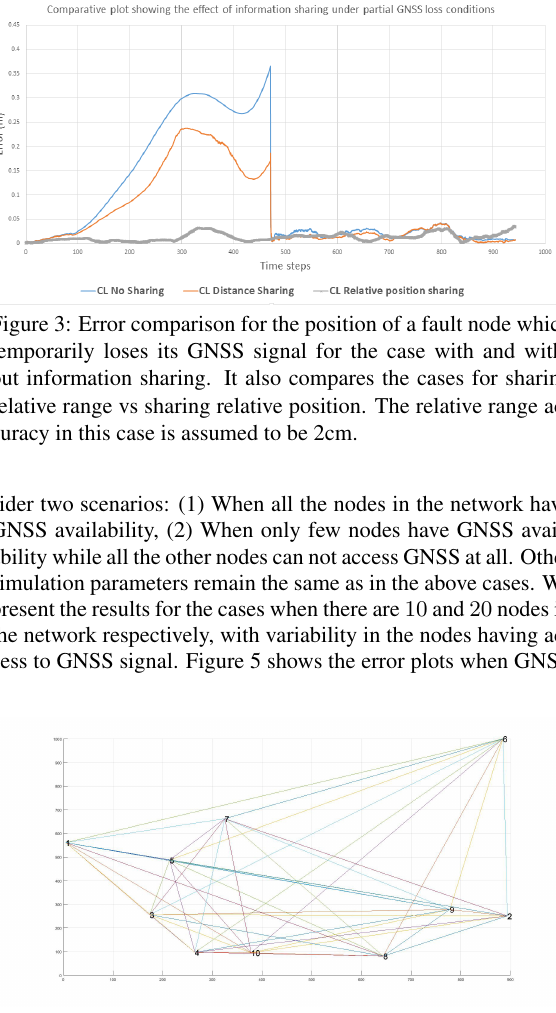
Figure 4: Network geometry at a given time instant with 10 nodes in the network with each node having full GNSS availability. The lines in the network represent the interactions between the nodes and the numbers represent the identification of the